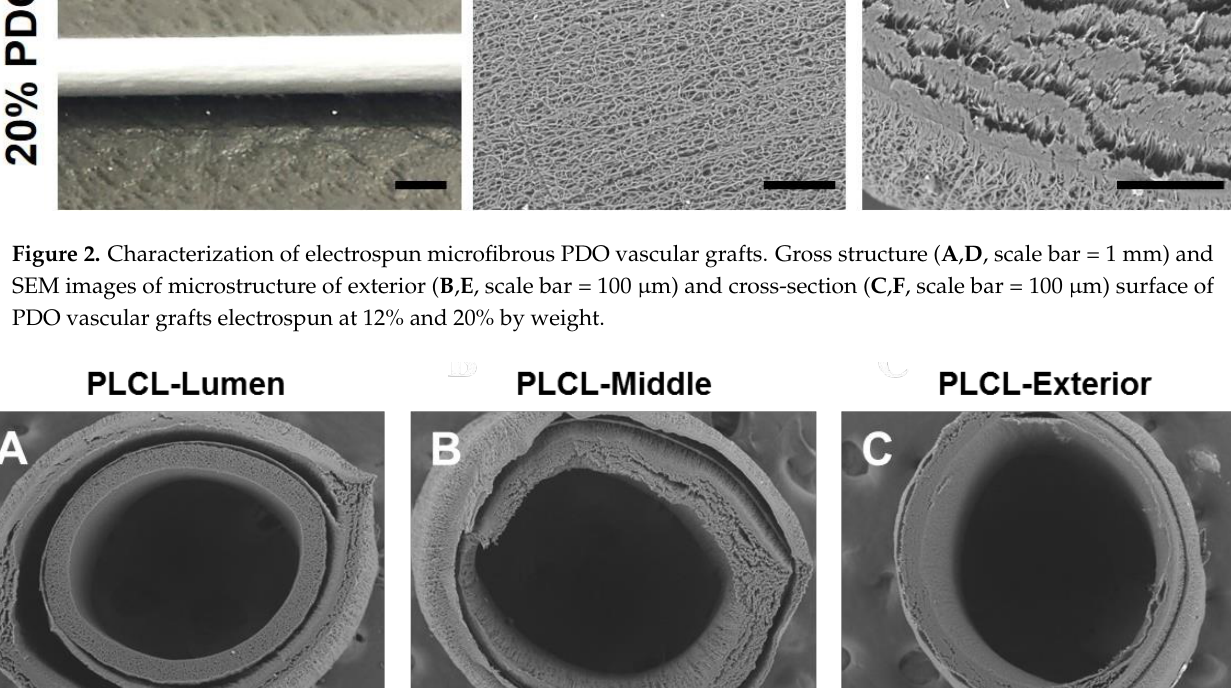
Figure 2. Characterization of electrospun microfibrous PDO vascular grafts. Gross structure ( A , D , scale bar = 1 mm) and SEM images of microstructure of exterior ( B , E , scale bar = 100 μm) and cross-section ( C , F , scale bar = 100 μm) surface of PDO vascular grafts electrospun at 12% and 20% by weight.